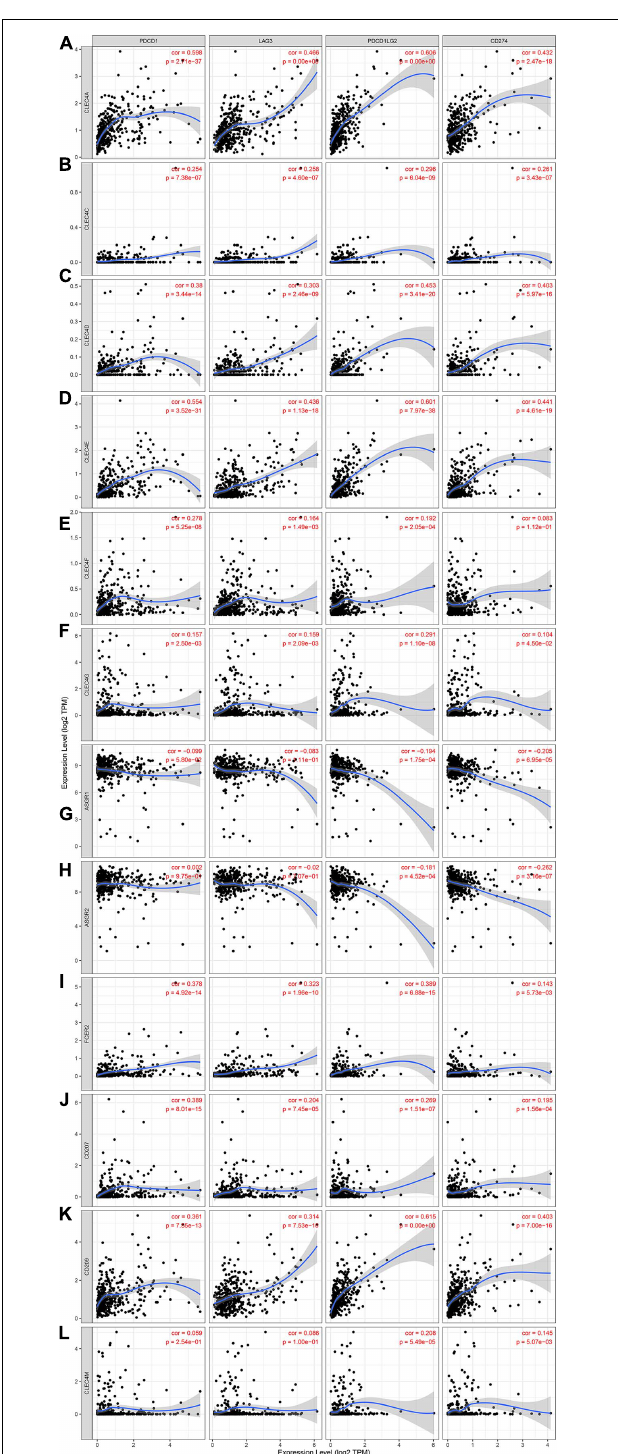
FIGURE 8 | The correlation between different expressed CLEC4s and PDCD1/LAG3/PDCD1LG2/CD274 (TIMER). The correlation between the abundance of immune cell and the expression of (A) CLEC4A, (B) CLEC4C, (C) CLEC4D, (D) CLEC4E, (E) CLEC4F, (F) CLEC4G, (G) CLEC4H1, (H) CLEC4H2, (I) CLEC4J, (J) CLEC4K, (K) CLEC4L, and (L) CLEC4M in